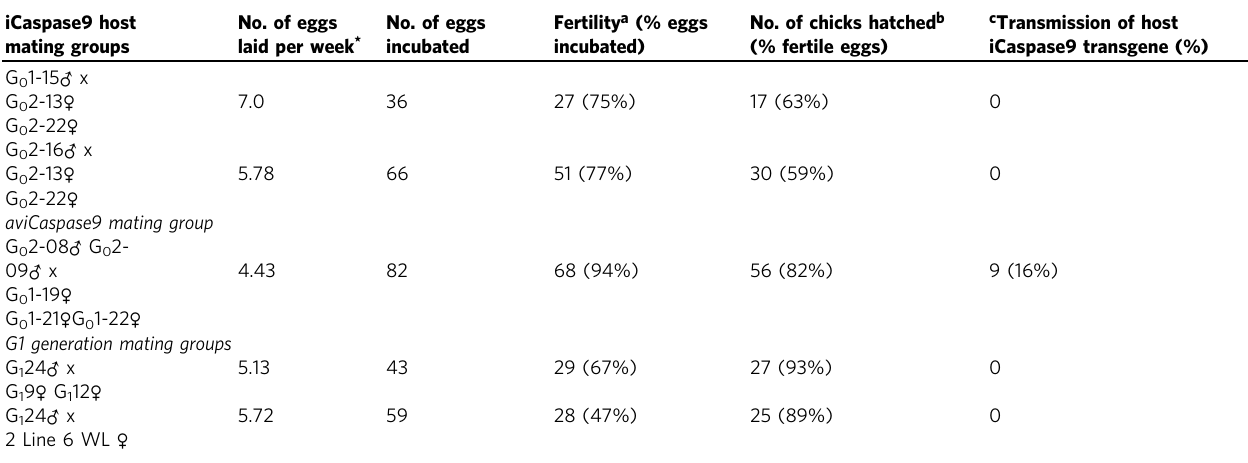
a Fertility: no. of eggs with embryos at day 18 of incubation detected by candling. b Hatchability: no. of chicks hatched from fertile day 18 eggs. c No. of offspring PCR + for iCaspase9